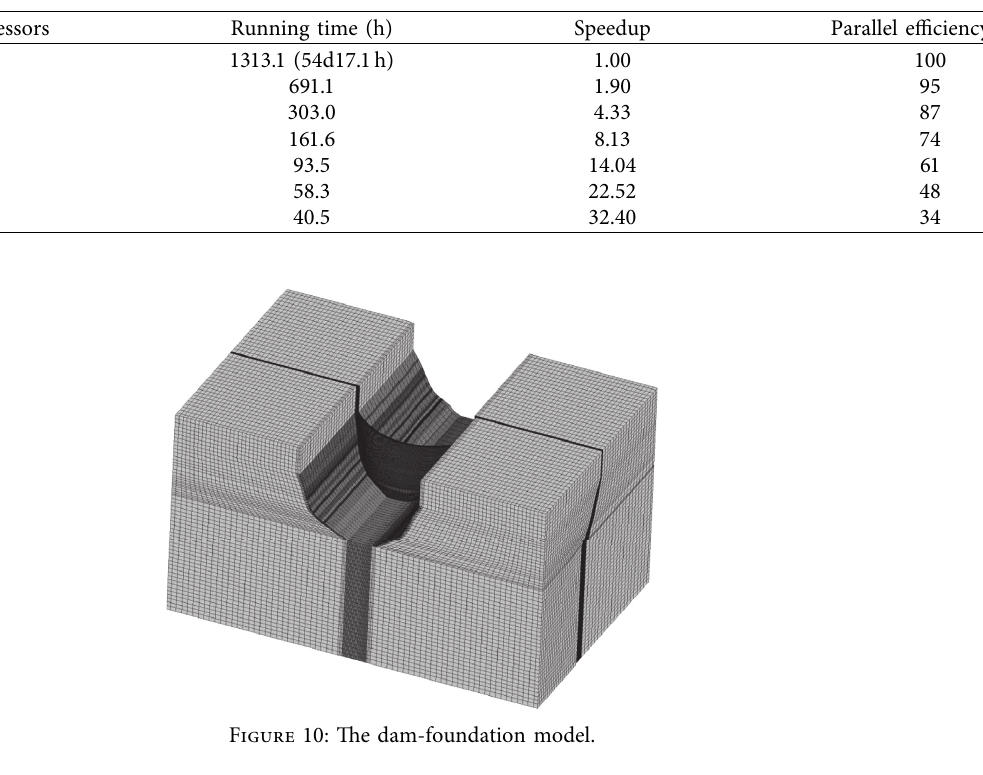
Table 1: Parallel computation test value.